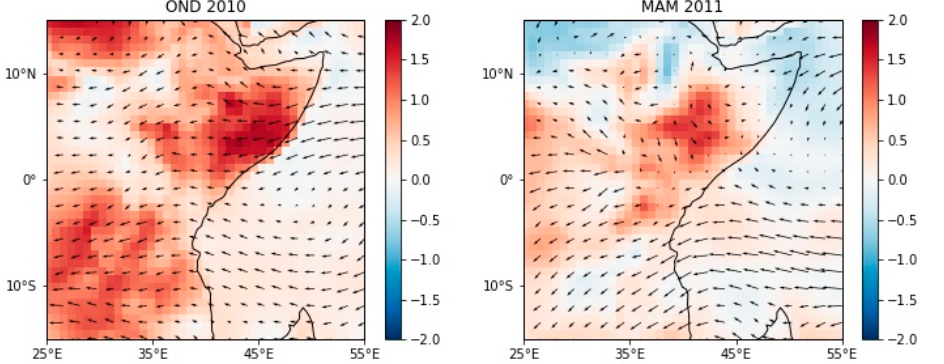
Figure 9. Anomalies of 2 m surface air temperature (filled colors) and 850 hPa wind (vectors). Temperatures generally increased in East Africa during the 2010–2011 failed rains. This contributes to but may also exist as a positive feedback with decreased photosynthetic activity: photosynthesis decreases at higher temperatures, but surface temperatures increase with the resulting reduced transpiration. OND is October, November, December; MAM is March, April, May.